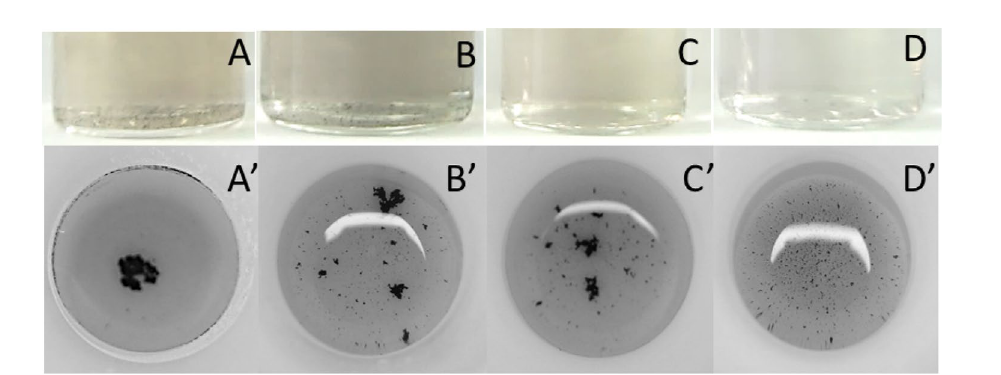
Figure 3. PtNPs synthesis in the microwave autoclave reactor: ( A ) parameters controlled during synthesis; ( B ) maximal value of temperature as a function of heating time; experimental conditions: [Pt(IV)] = 1 × 10 −4 M, [TSC] = 2 × 10 −3 M.